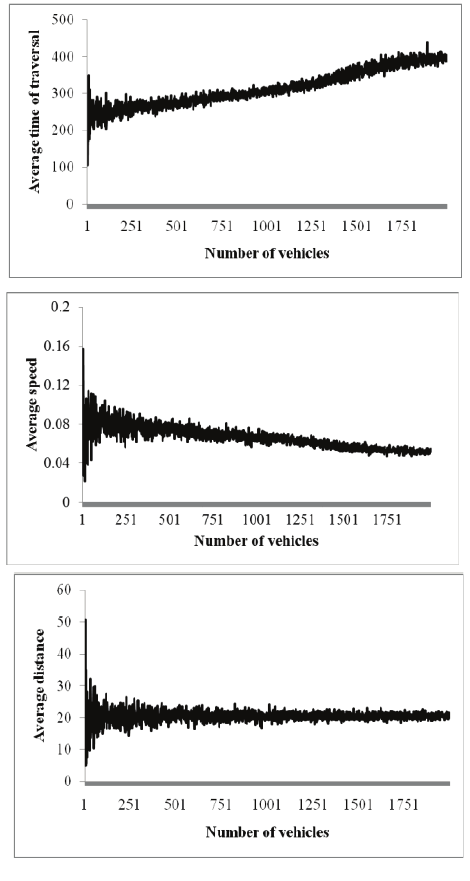
Fig. 11. Analysis for integrated